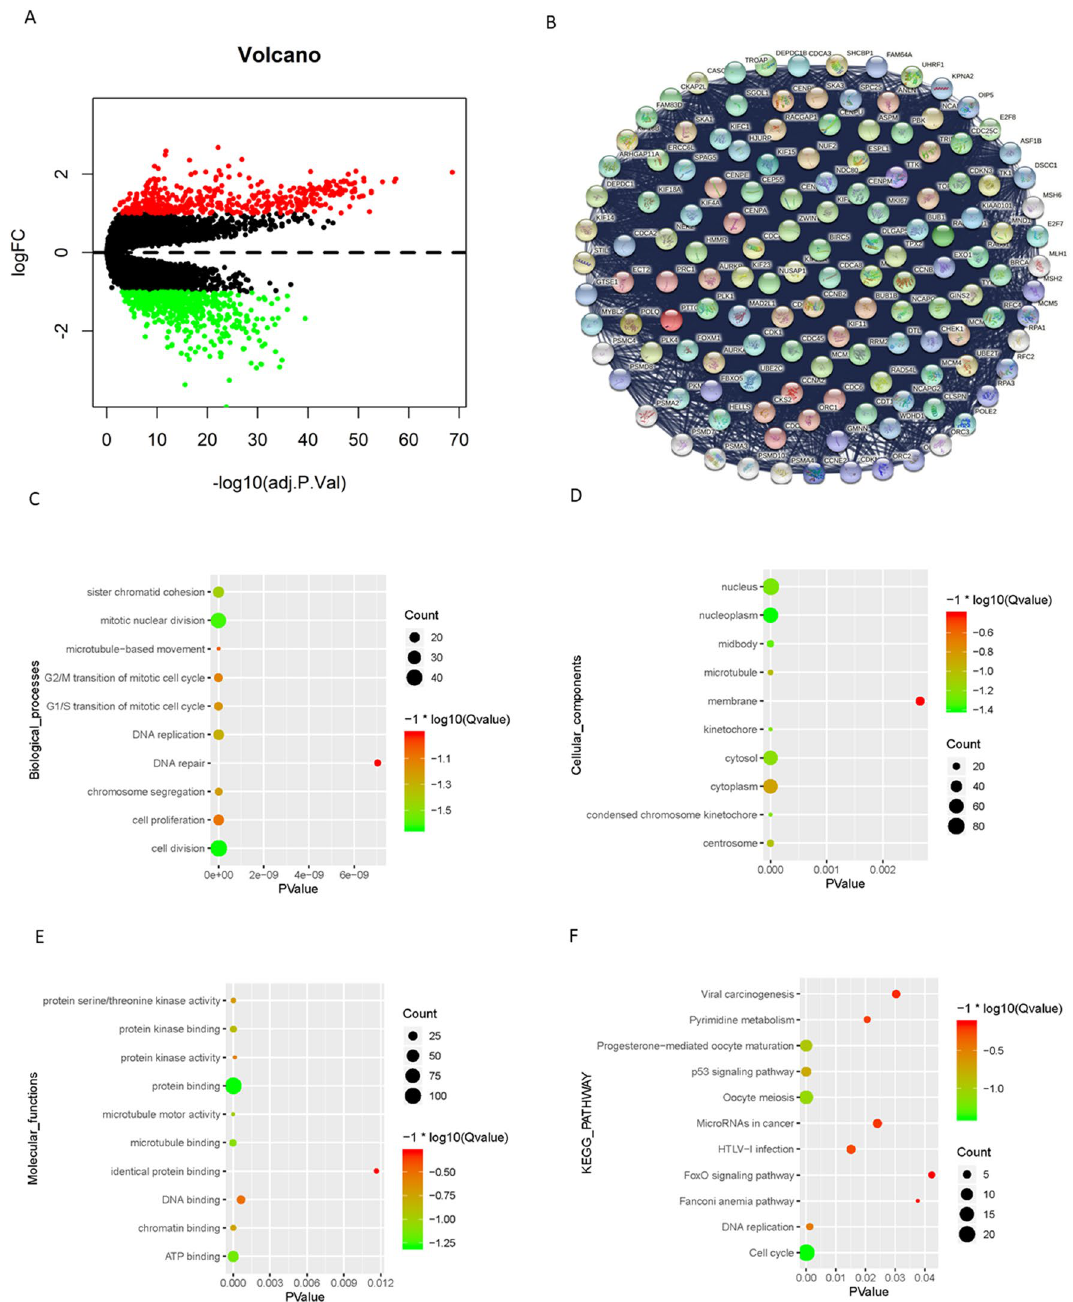
Figure 4. Identification hypoxic-related differentially expressed genes (DEGs) and enrichment analysis. ( A ) Volcano plot for DEGs in cluster1 and cluster2. Red and green dots represent up-regulated and down- regulated DEGs in cluster1 relative to cluster2, respectively (P < 0.01, |logFC|> 1). ( B ) PPI network of a crucial sub-network with 119 nodes and 6153 edges among DEGs. ( C – E ) The top 10 items of GO analysis: biological processes, molecular functions and cellular components of the DEGs in the sub-network. ( F ) Pathway enrichment analysis of the DEGs in the